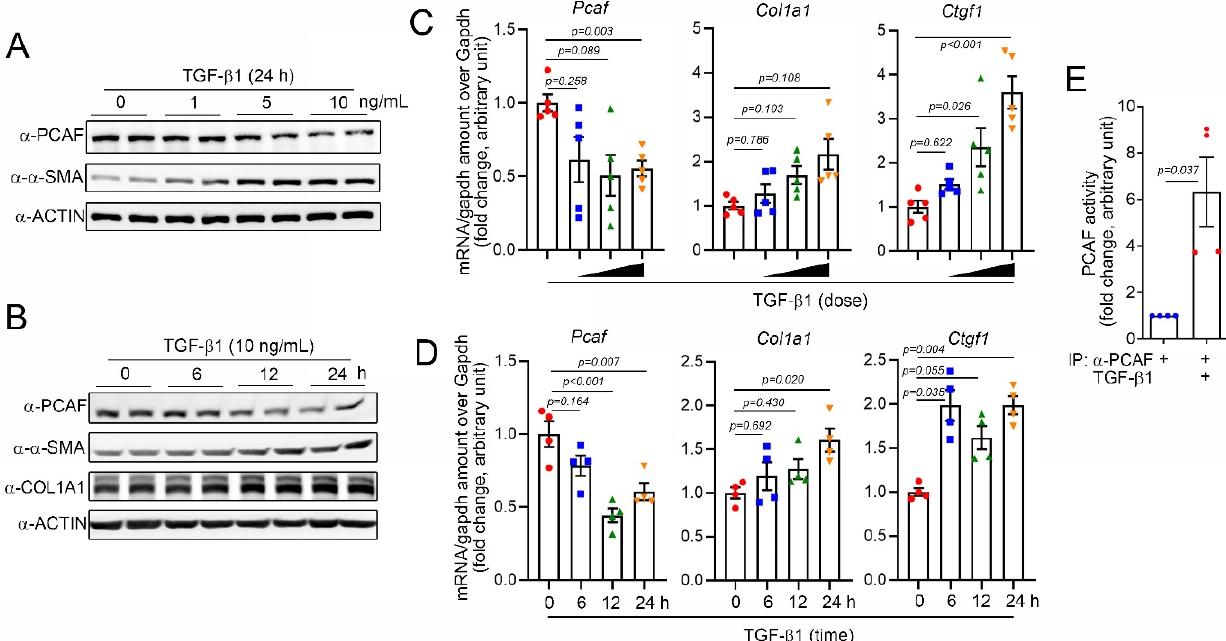
Figure 2. TGF-β1 reduced PCAF mRNA and protein but induced its acetylase activity. ( A ) TGF-β1, a fibrosis-inducing cytokine, decreased the PCAF protein amount in a time-dependent manner, whereas it increased α-SMA. ( B ) Dose-dependent effect of TGF-β1 on the PCAF protein reduction. ( C ) Changes in mRNA level determined by quantitative RT-PCR with TGF-β1 0–10 ng/mL used for 24 h. ( D ) Changes in mRNA level determined by quantitative RT-PCR with TGF-β1 (10 ng/mL) treated for 0–24 h. Both COL1A1 and CTGF are fibrosis markers. ( E ) TGF-β1 significantly increased the PCAF acetylase activity.